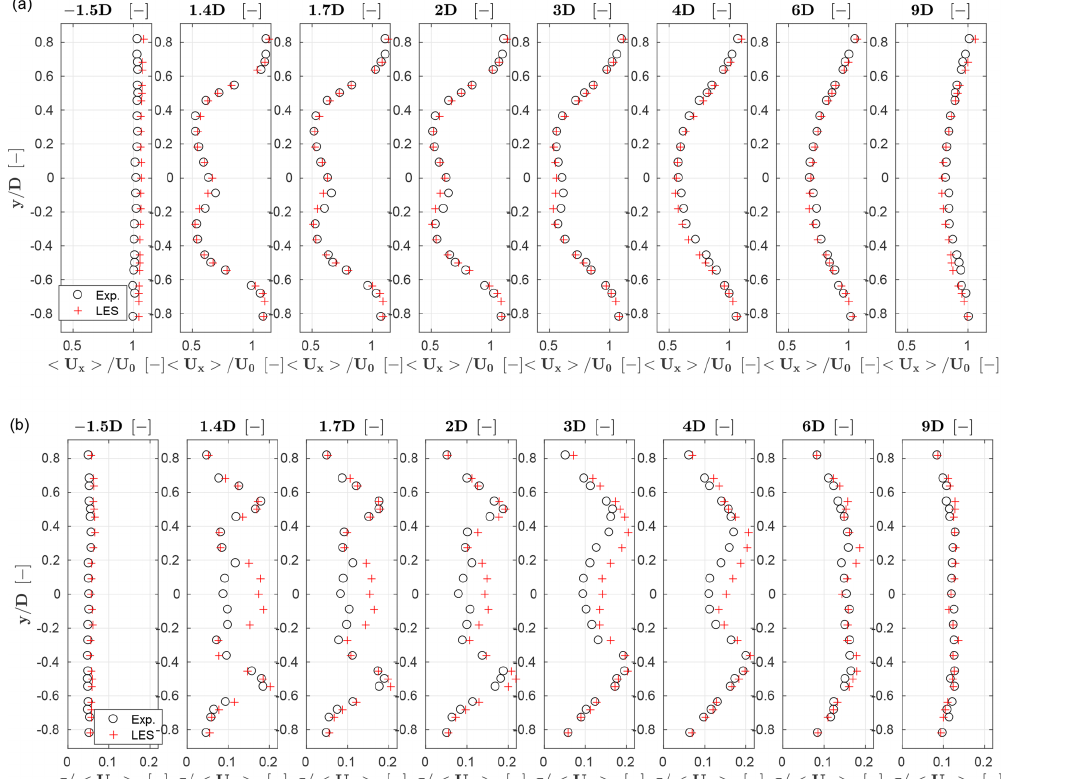
Figure 9. Normalized time-averaged streamwise velocity (cid:104) u x (cid:105) /U 0 (a) and turbulence intensity σ/ (cid:104) u x (cid:105) (b) profiles at hub height. Red + symbols: LES; black ◦ symbols: experimental results.